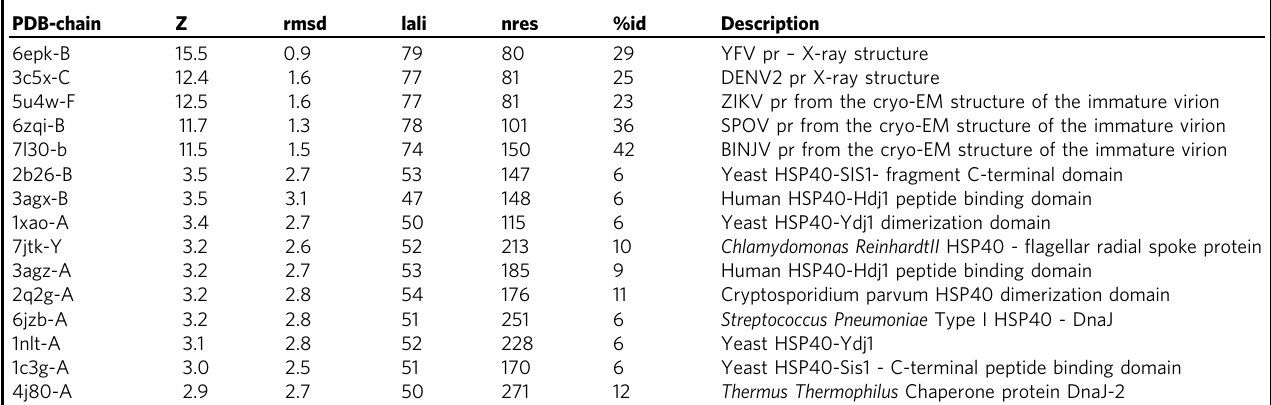
Table 1 List of structural neighbors of TBEV pr found by the Dali server 31, 65 sorted by Z-score. Only matches with Z-score > 2.8 are